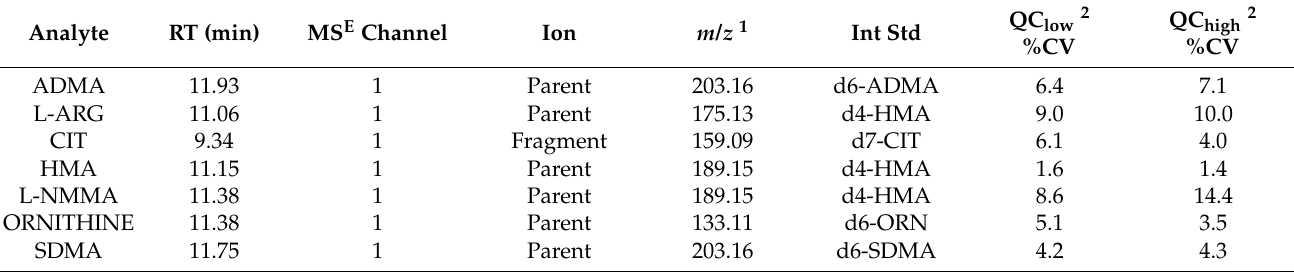
Table 1. Retention times, corresponding parent or fragment mass, MS E acquisition channel and quality performance (QC) performance data (five independent determinations at each of two concentrations) for each